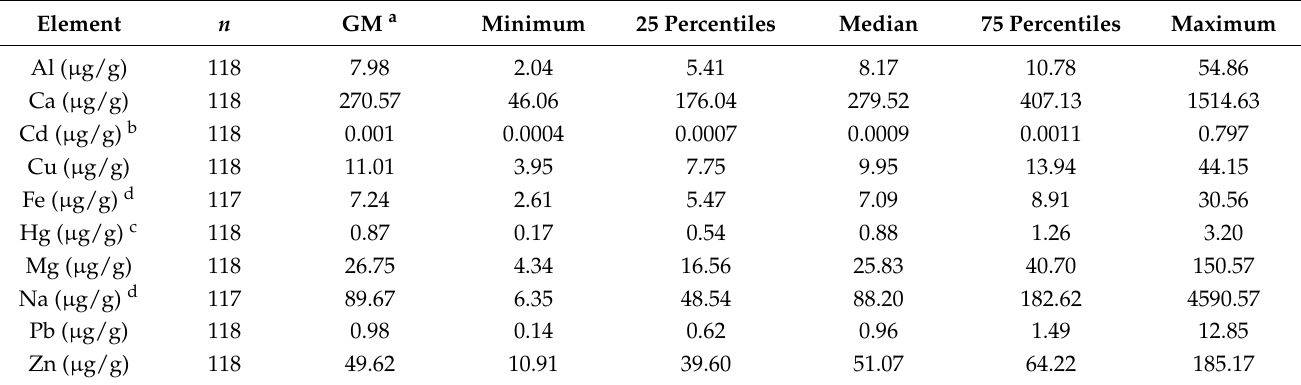
Table 2. Concentration of elements in the hair of Japanese children.